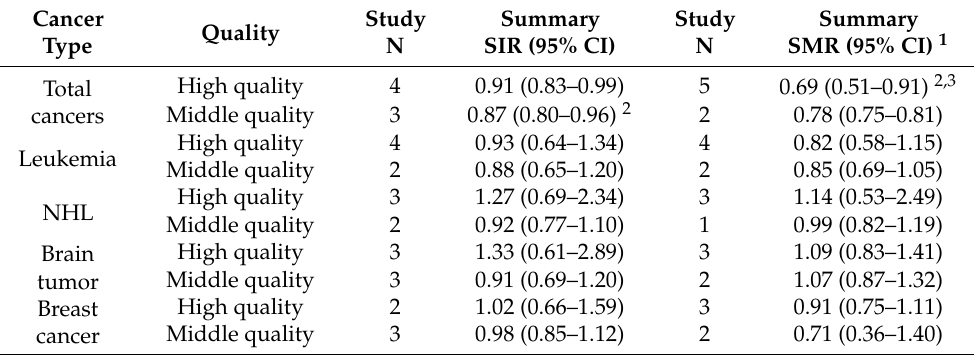
Table 6. Sub-group meta-analysis by study quality for the standardized incidence ratios (SIRs) and standardized mortality ratios (SMRs) of cancer, leukemia, NHL, brain tumor and breast cancer in semiconductor workers compared to the general